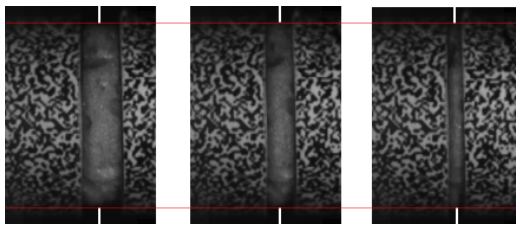
Figure 8. Comparison of intact and deformed state of polyurethane foam specimen.